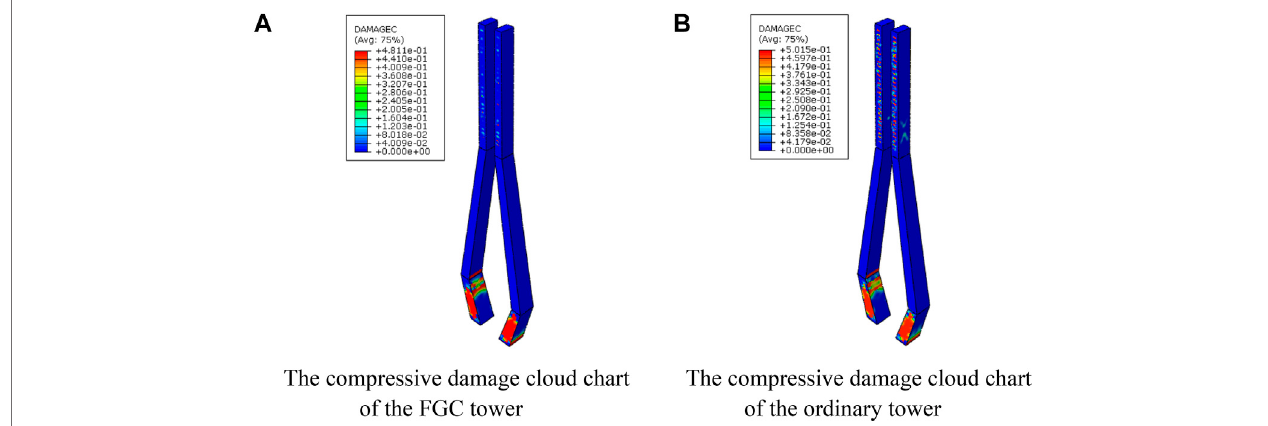
FIGURE 17 | The compressive damage cloud chart of the two different materials models. (A) The compressive damage cloud chart of the FGC tower. (B) The compressive damage cloud chart of the ordinary tower.